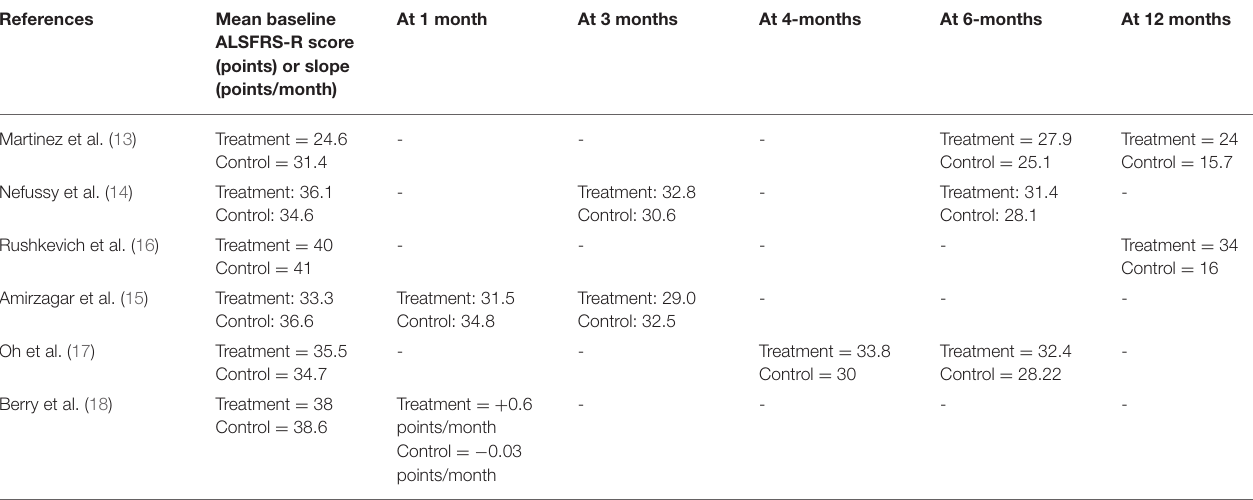
TABLE 2 | Model for ALSFRS-R mean baseline scores/slopes and mean scores/slopes after stem cell therapy at different follow-up